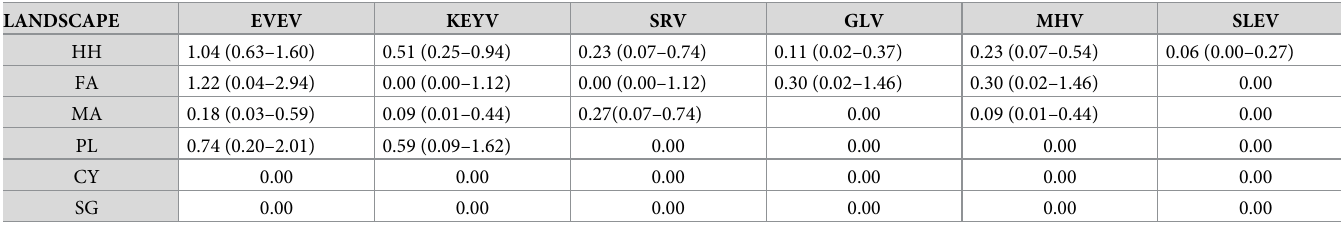
Table 2. Minimum infection rate per 1,000 mosquitoes (95% CI) among landscapes 2013. LANDSCAPE